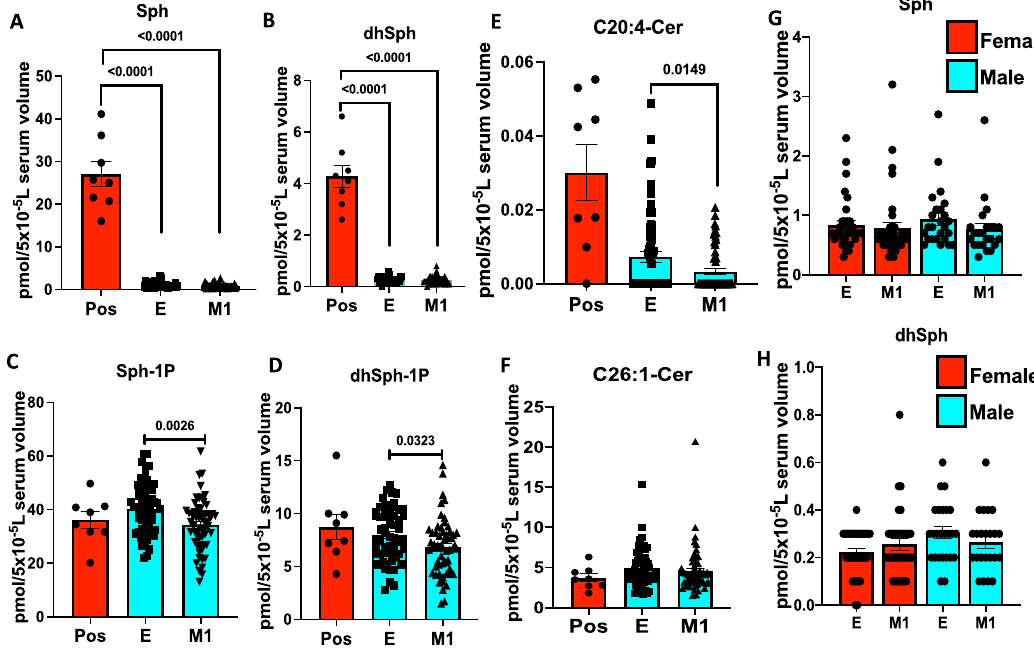
Figure 2. Reduced serum sphingosine level in COVID-19 patients, is not associated with the diseases’ severity. LC–MS/MS measurements for ( A ) Sphingosine (Sph), ( B ) dihydro-sphingosine (dhSph), ( C ) sphingosine 1-phosphate (Sph-1p), and ( D ) dihydro-sphingosine 1-phosphate (dhSph-1p). LC–MS/MS ceramide (Cer) measurements for ( E ) C20:4-Cer, and ( F ) C26:1 Cer. ( G , H ) Sph ( G ) and dhSph ( H ) levels of symptomatic COVID-19 patients in male and female patients. Pos asymptomatic positive antibody test (n = 8), E enrolled at time of diagnosis (n = 60), M1 one month of recovery (n = 59). Data are means of ± SEM, and P < 0.05 is considered